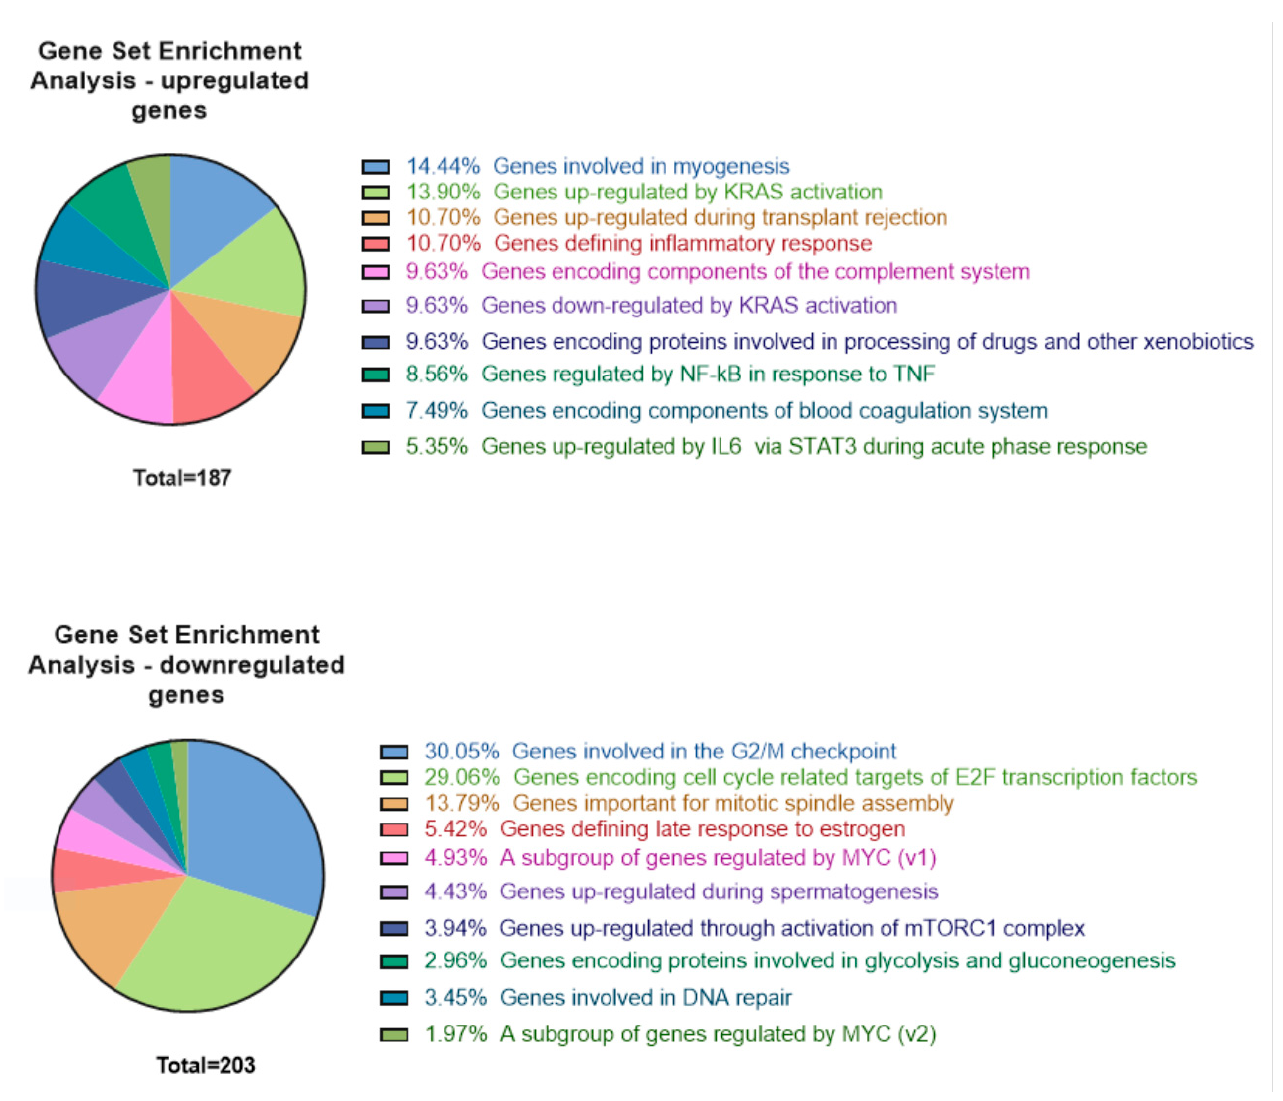
Figure 5. Distribution of hallmark genes that represent well-defined biological states or processes. Diagrams present the distribution of 1434 significantly upregulated and 356 downregulated genes (fold change ≥ |10|). Analysis was performed using the GSEA (Gene Set Enrichment Analysis) online tool. Numbers below the pie charts show the number of genes with the assigned function hit. Regarding the large group of upregulated genes classified by GSEA as genes involved in myogenesis, Figure 6 presents a list of twenty six genes with at least 10-times increased expression. Among them there are genes encoding major contractile and regulatory muscle proteins and proteins involved in Ca 2+ transport and